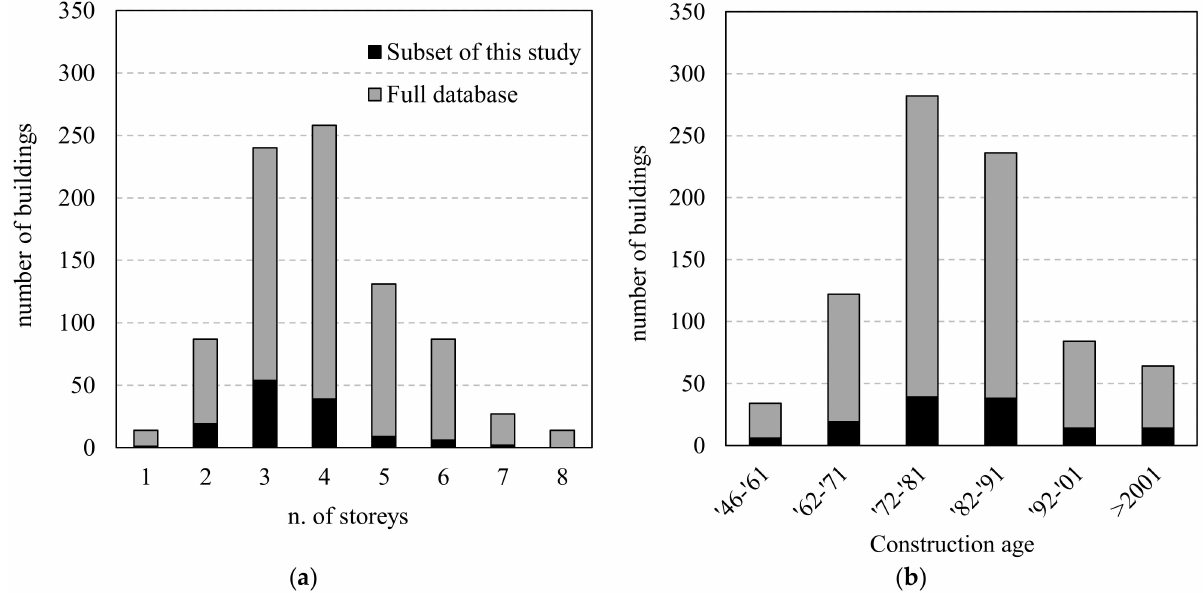
Figure 3. Distribution of the complete database of FRP-strengthened buildings (FRP and Other + FRP) (858 buildings) and the subset used in this study (130) in relation to: n. of storeys ( a ); construction age ( b